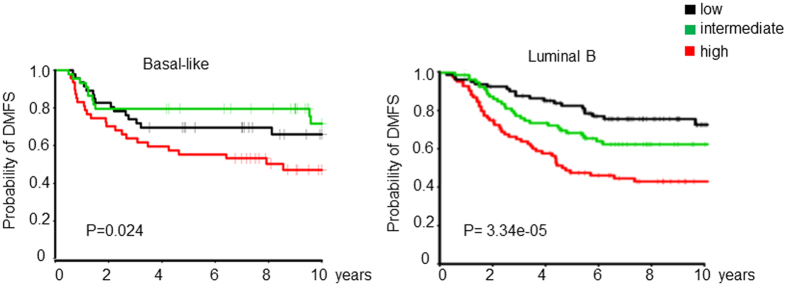
KM plot showed that high 3q gene signature was significantly associated with worse distant metastasis free survive (DMFS) in basal-like (n = 137) and luminal B (n = 254) subtypes of node-negative breast cancer patients (n = 788).The log-rank P values are shown.